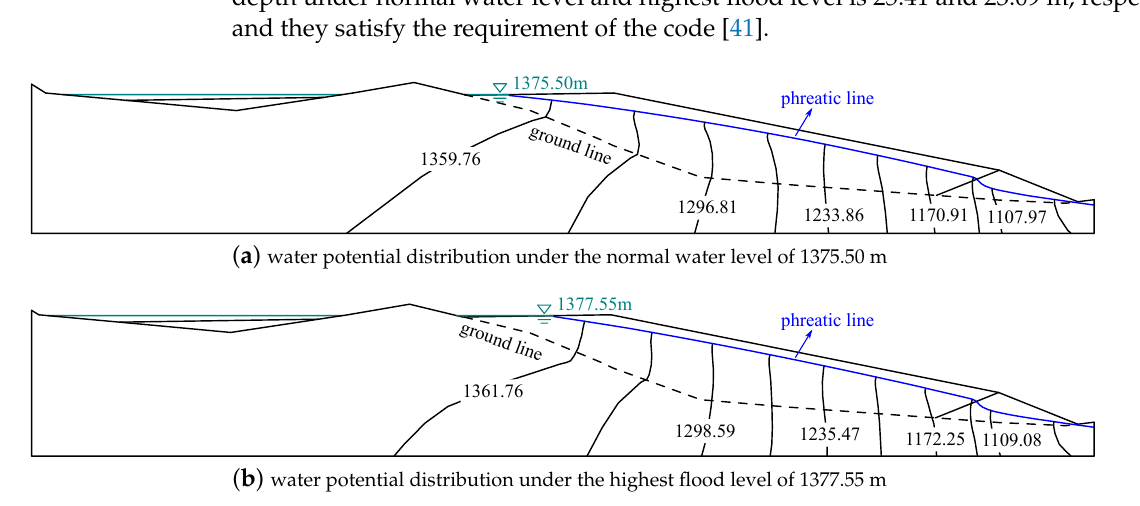
Figure 13. The water potential distributions in the section in the tailings dam under different water levels (m). The phreatic line under the highest flood level is higher than that under the normal water level, and the minimum buried depths of phreatic lines under these water levels address the requirement of the code